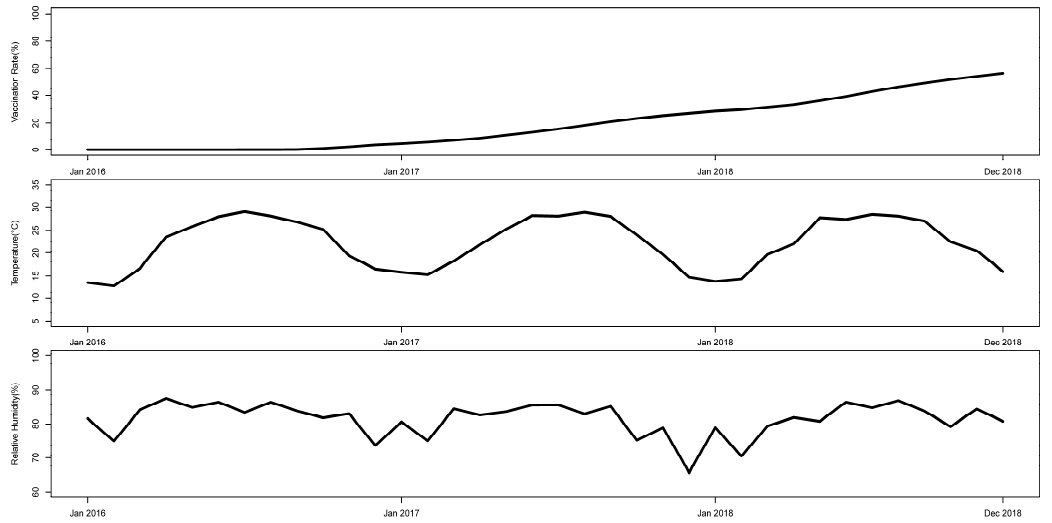
Figure 3. Observed trends in vaccination rates and climate factors from 2016 to 2018 in Guangzhou, China.